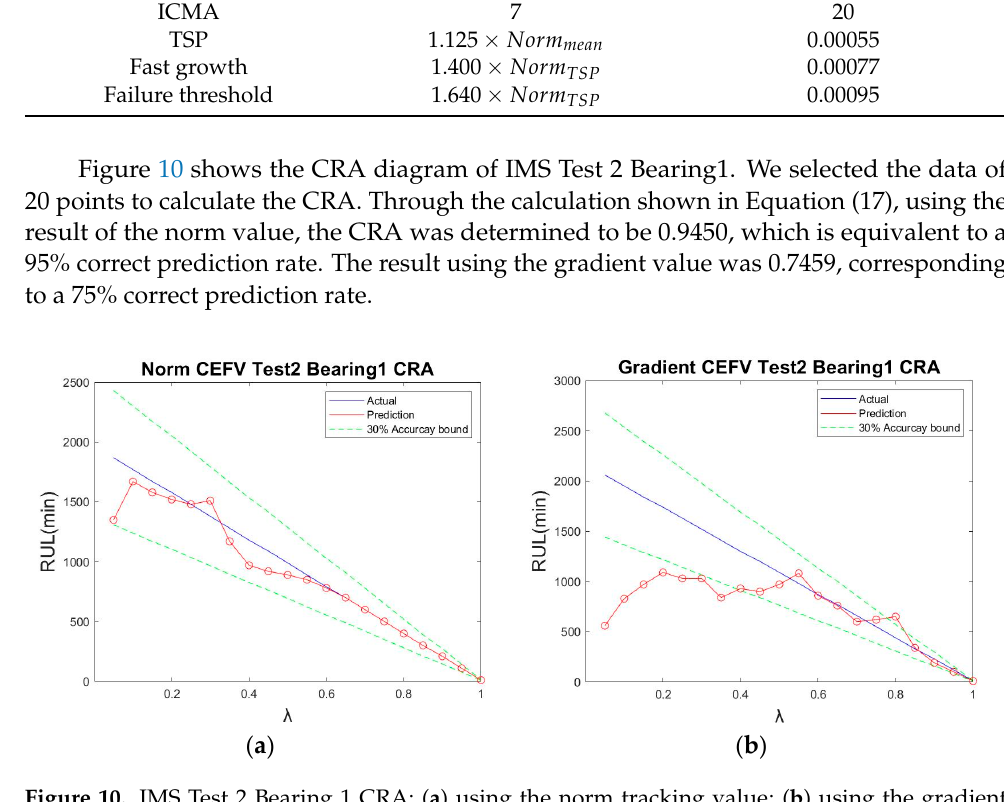
Figure 10. IMS Test 2 Bearing 1 CRA: ( a ) using the norm tracking value; ( b ) using the gradient tracking value.